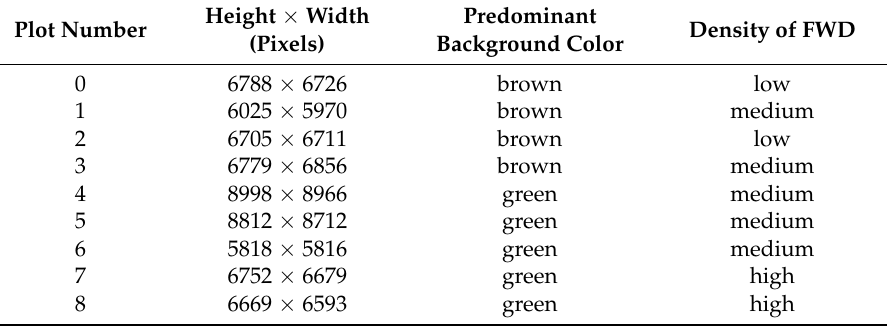
Table 2. Characteristics of plots used in